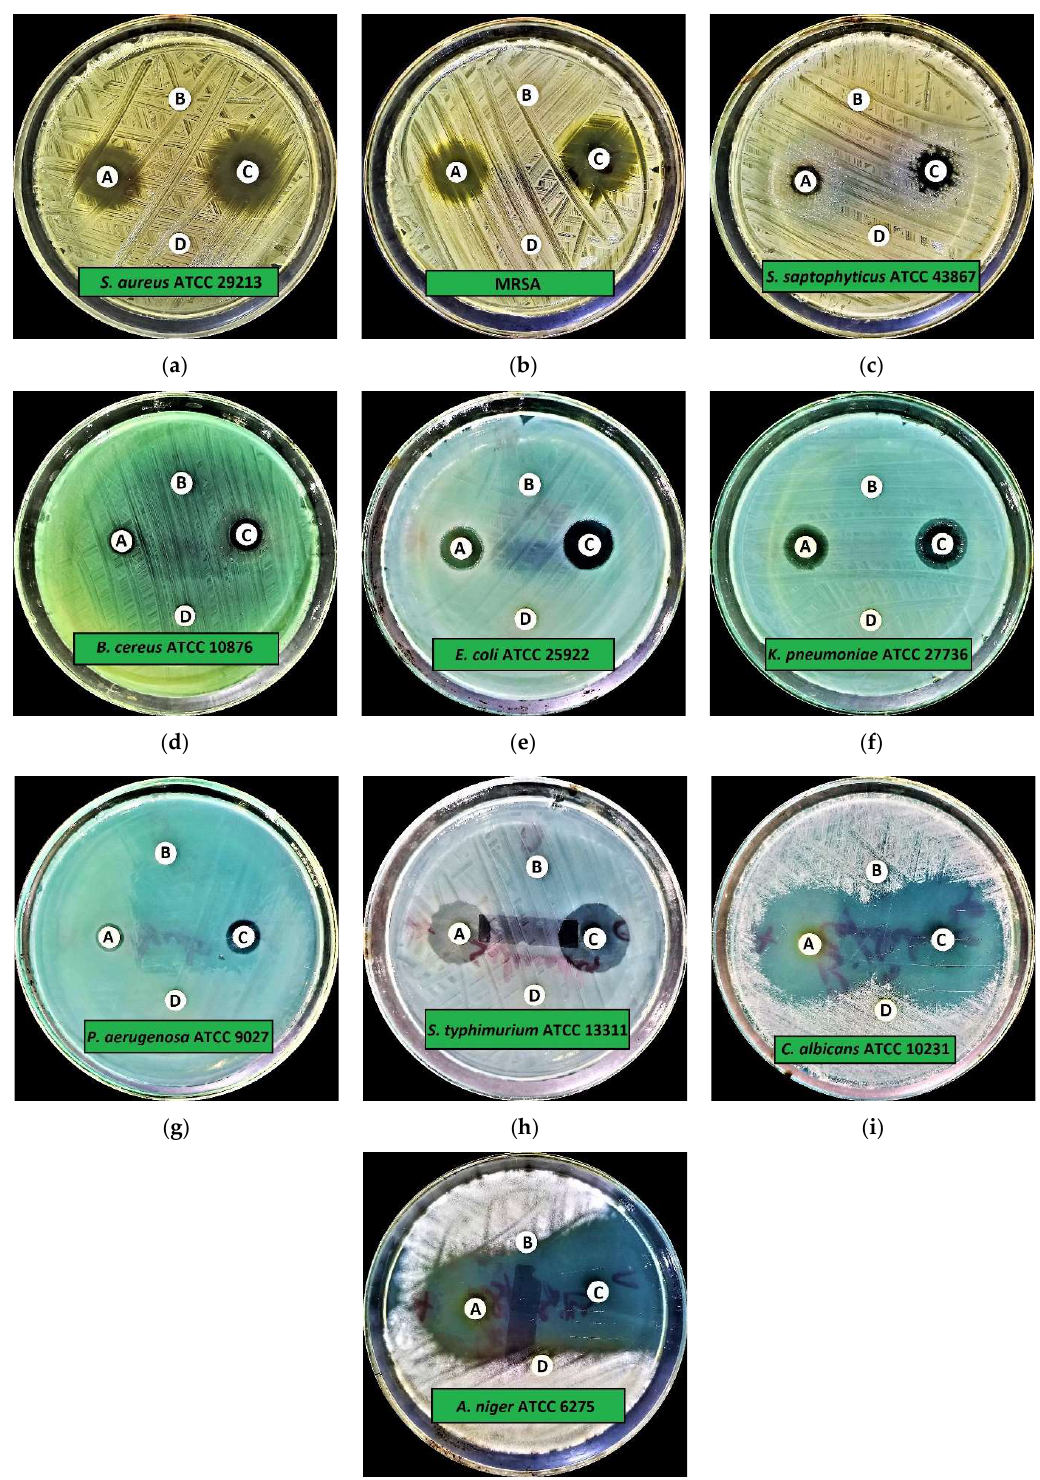
Figure 2. Preliminary antimicrobial activity of CA-SNEDDS: ( a ) S. aureus ATCC 29213; ( b ) MRSA; ( c ) S. saptophyticus ATCC 43867; ( d ) B. cereus ATCC 10876; ( e ) E. coli ATCC 25922; ( f ) K. pneumoniae ATCC 27736; ( g ) P. aeruginosa ATCC 9027; ( h ) S. typhimurium ATCC 13311; ( i ) C. albicans ATCC 10231; ( j ) A. niger ATCC 6275. Note: A = CA-SNEDDS; B = SNEDDS; C = Positive control; D = Negative control.